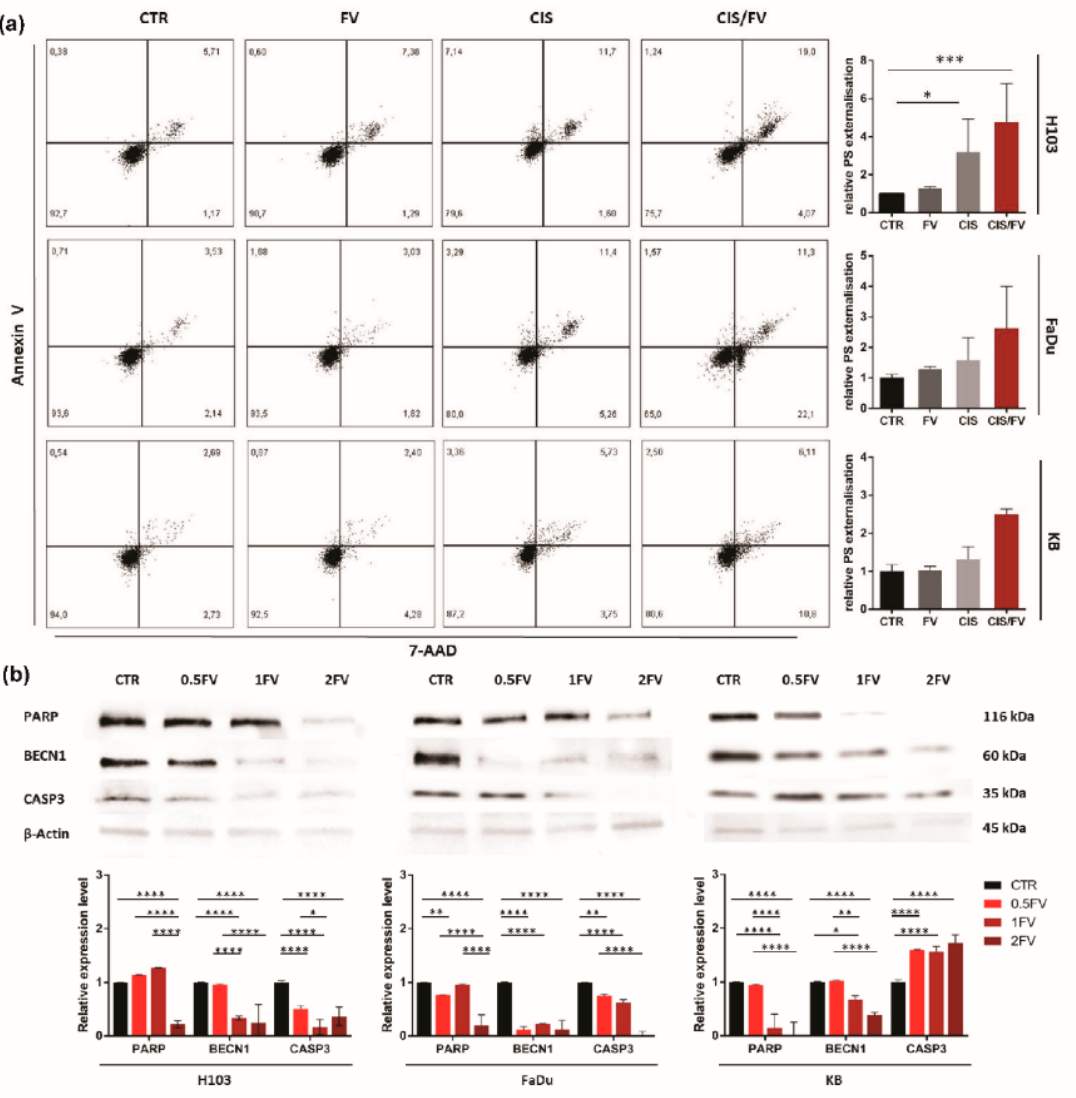
Figure 3. Impact of fucoidan on the induction of apoptosis in HNSCC cell lines: H103, FaDu, KB ( a ): 24 h incubation with fucoidan induces apoptosis in all tested cell lines (CTR—control, 0.5FV—half-